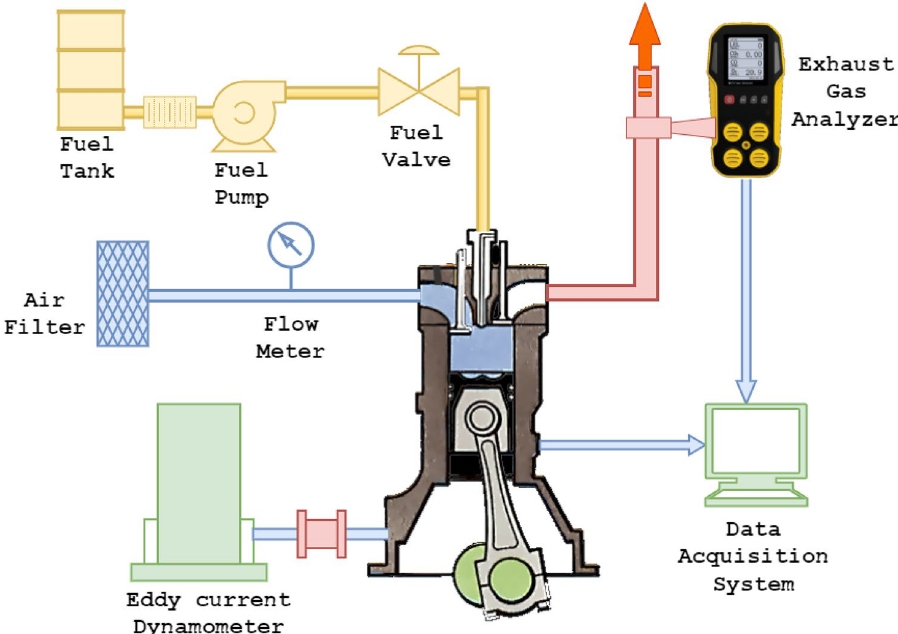
Figure 1. Schematic diagram of experimental engine setup.